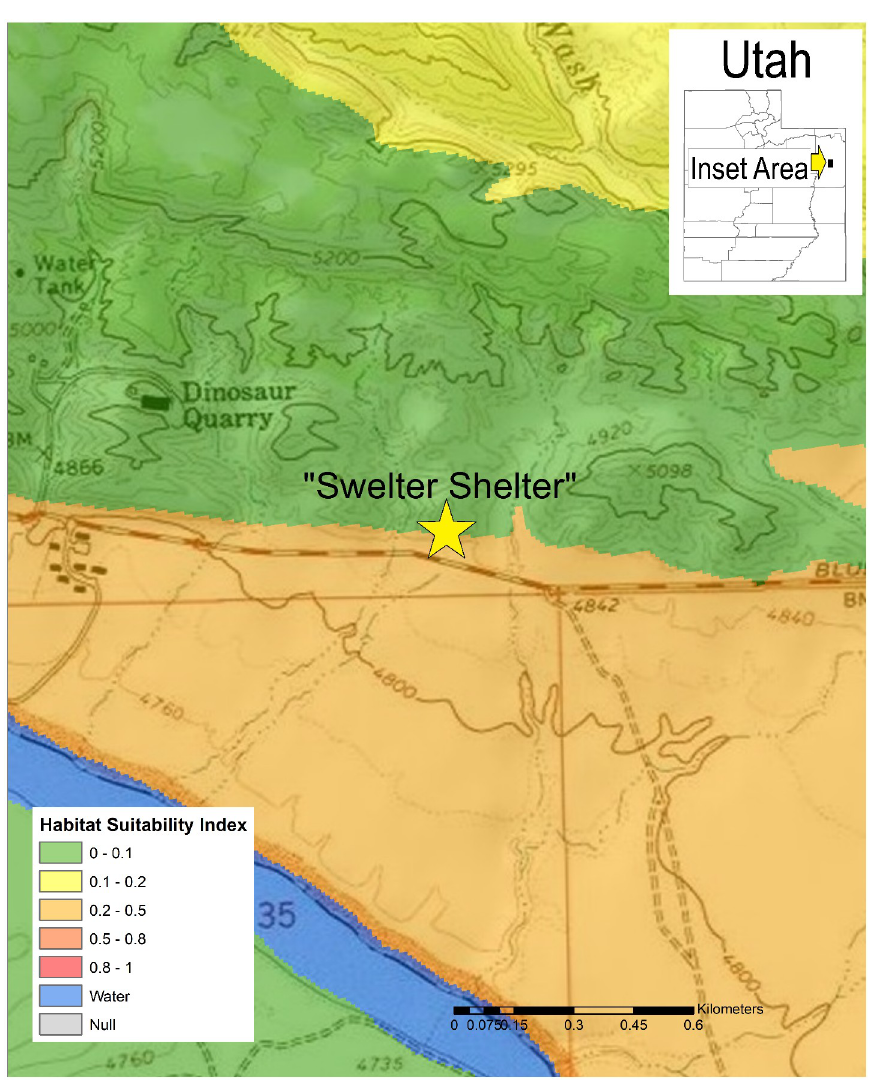
Fig 7. Predicted Coccidioides habitat suitability index for Dinosaur National Monument,